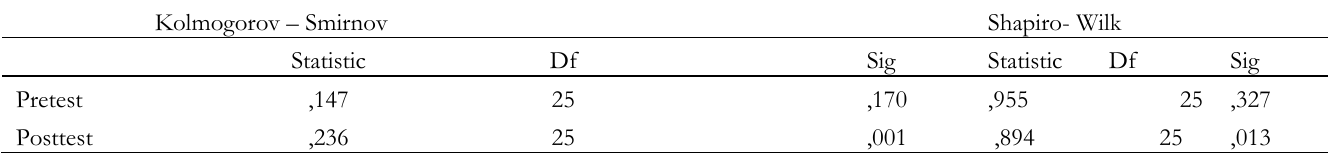
TABLE 2. Test of